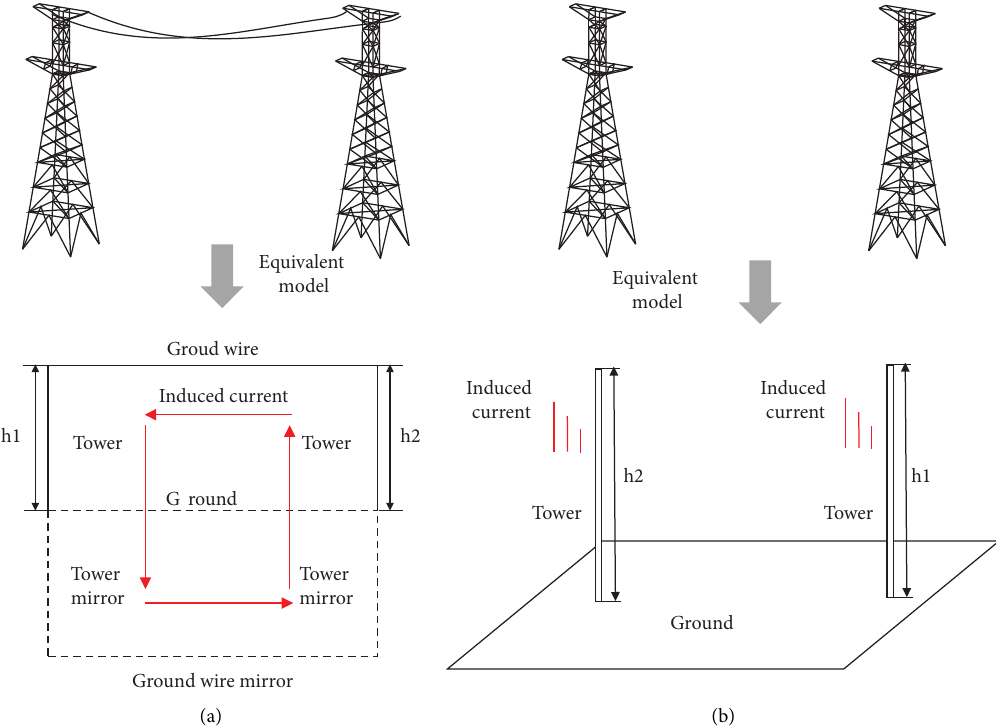
Figure 1: Equivalent models of PTL for one span. (a) Te equivalent model of the loop antenna. (b) Te equivalent model of wire